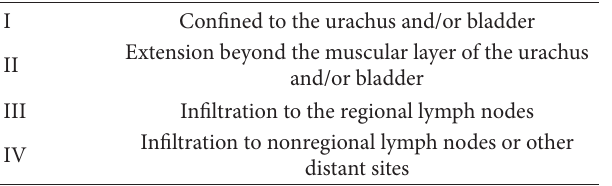
Table 2: Mayo staging